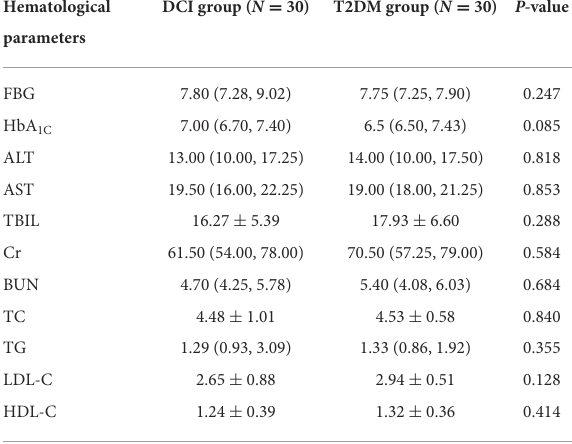
TABLE 1 The demographic characteristics and comprehensive assessment of DCI and T2DM participants.